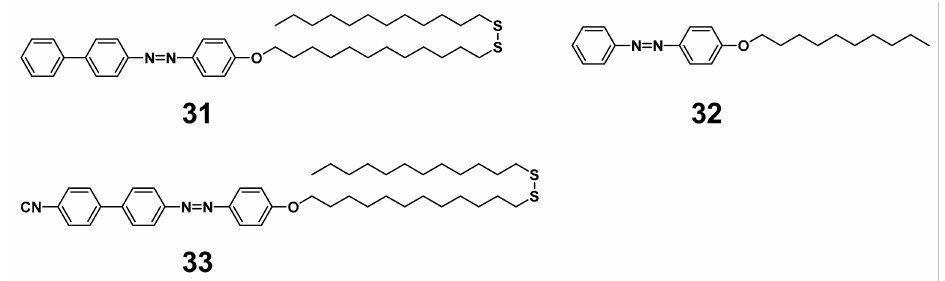
Figure 15. The molecular structure of azobenzene derivatives 30–33